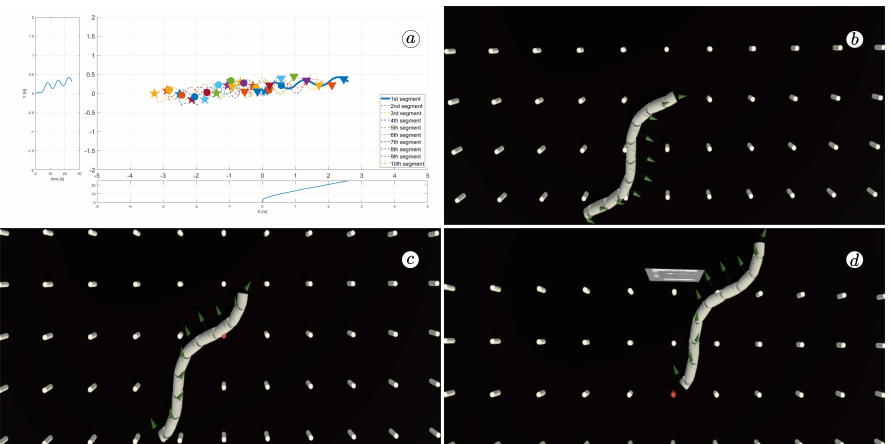
Figure 36. Trajectories of robot segments for φ i ,ref = 50 ◦ sin ( 50 ◦ t + ( i − 1 ) 50 ◦ ) ( a ) and robot configu- rations for t = 5 ( s ) ( b ), t = 10 ( s ) ( c ), and t = 24 ( s ) ( d ).